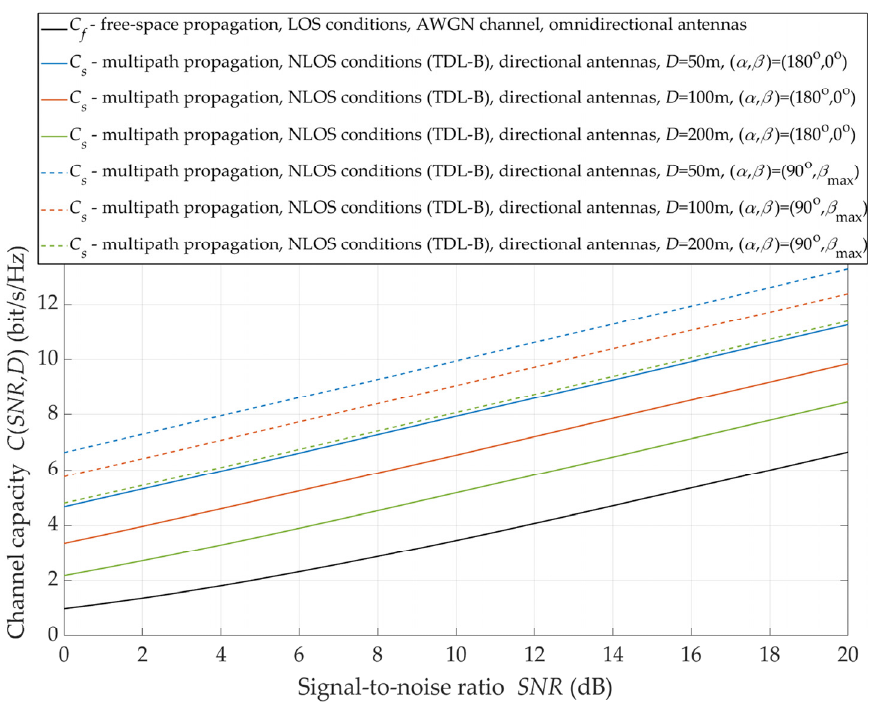
Figure 11. Capacity versus SNR for directional antenna pattern and under NLOS conditions.